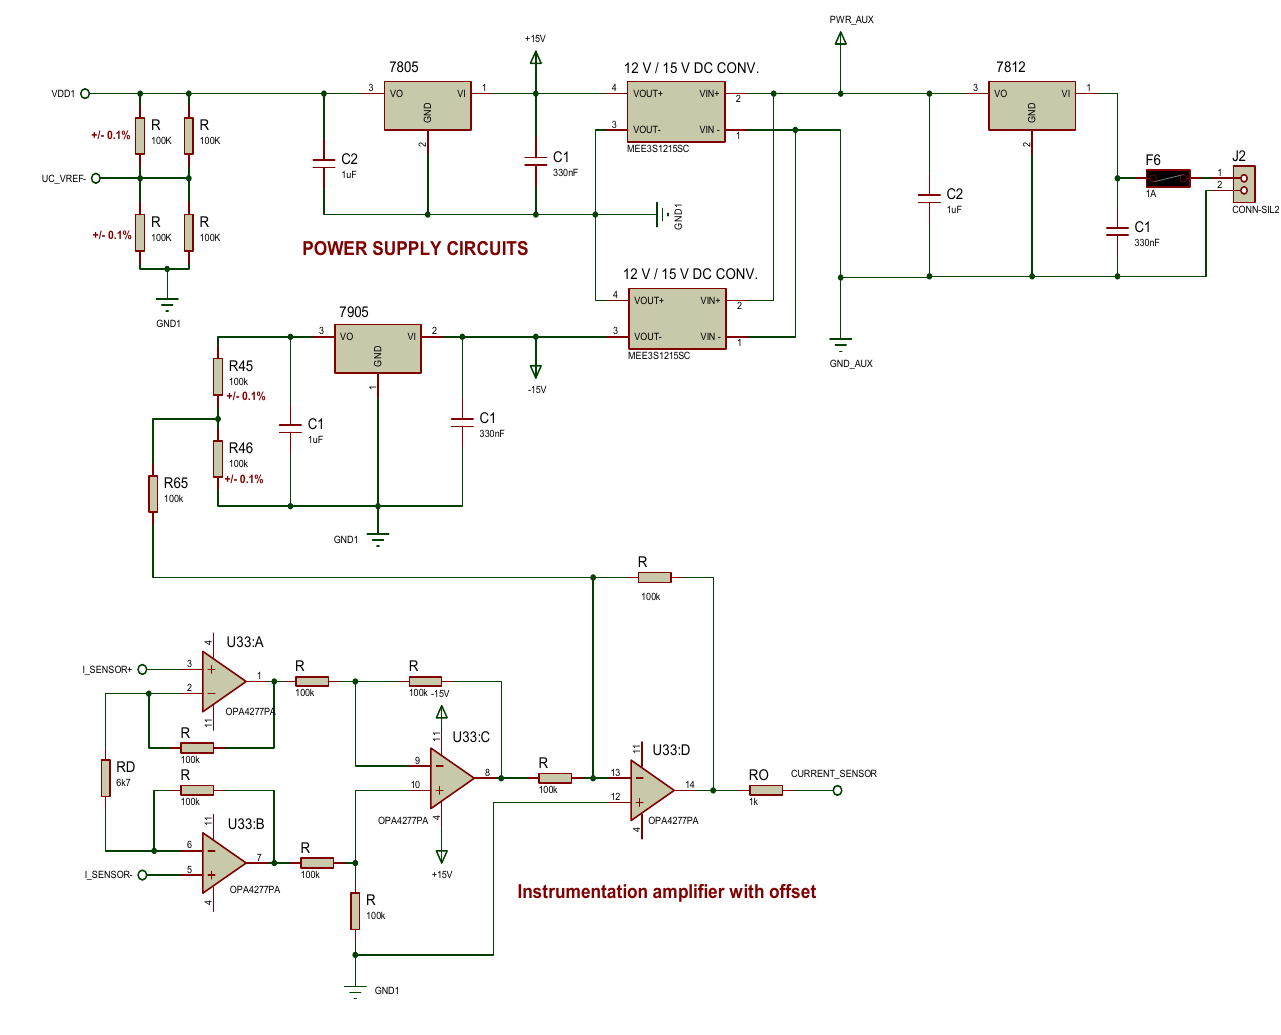
Figure 19. SSC slave control circuit ISIS model Part 3: voltages differential